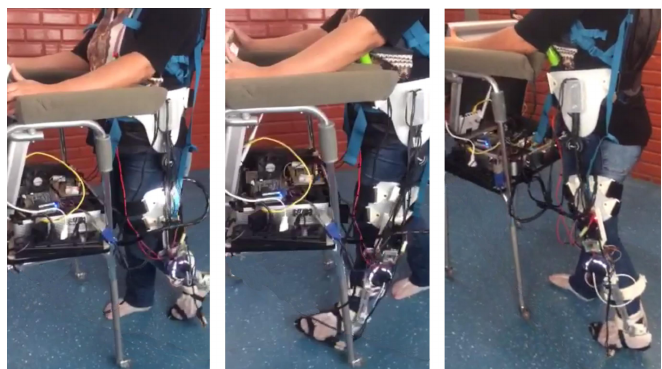
Figure 8. Sequence of an experiment conducted at 0.2 m/s by a subject wearing ALLOR with the stance control using the knee impedance modulation based on the knee moment during gait.